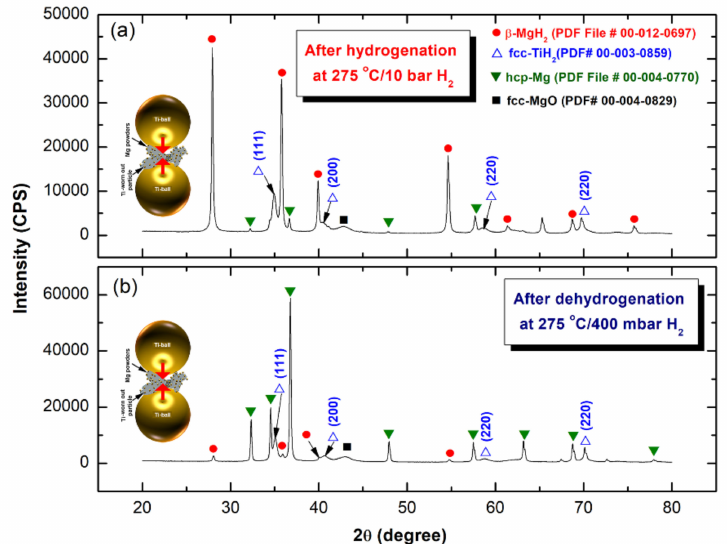
Figure 17. The XRD patterns of the 150 passes CR Mg-ribbons that were RBM for 100 h and then ( a ) hydrogenated at 275 ◦ C / 10 bar H 2 , and ( b ) dehydrogenated at 275 ◦ C / 400 mbar H 2